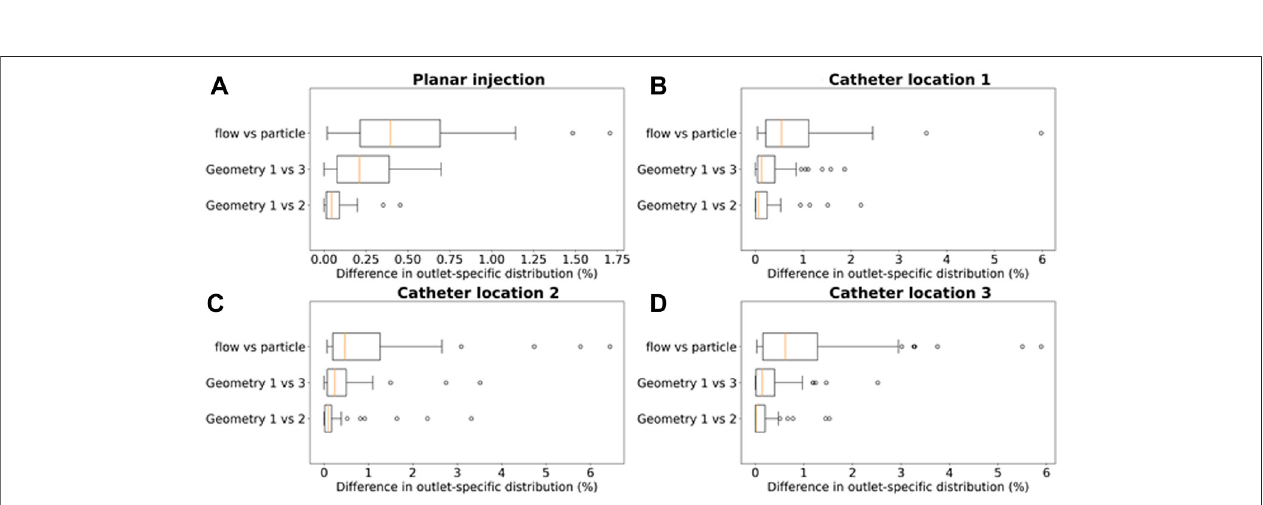
FIGURE 9 | Boxplots comparing the differences in outlet particle distribution ((T)CF in panel A, (T)EF for panels (B – D) in Geometry 1 and 2 ( “ Geometry 1 vs. 2 ” ), Geometry 1 and 3 ( “ Geometry 1 vs. 3 ” ), and the differences in fl ow distribution and particle distribution in Geometry 1 ( “ fl ow vs. particle ” ). This is done for each of the 4 simulation sets: (A) the planar injection, and (B – C – D) catheter locations 1 – 3. For the planar injection, the error range is clearly much smaller than for the catheter injections (maximum of 1.75 vs. 6%).